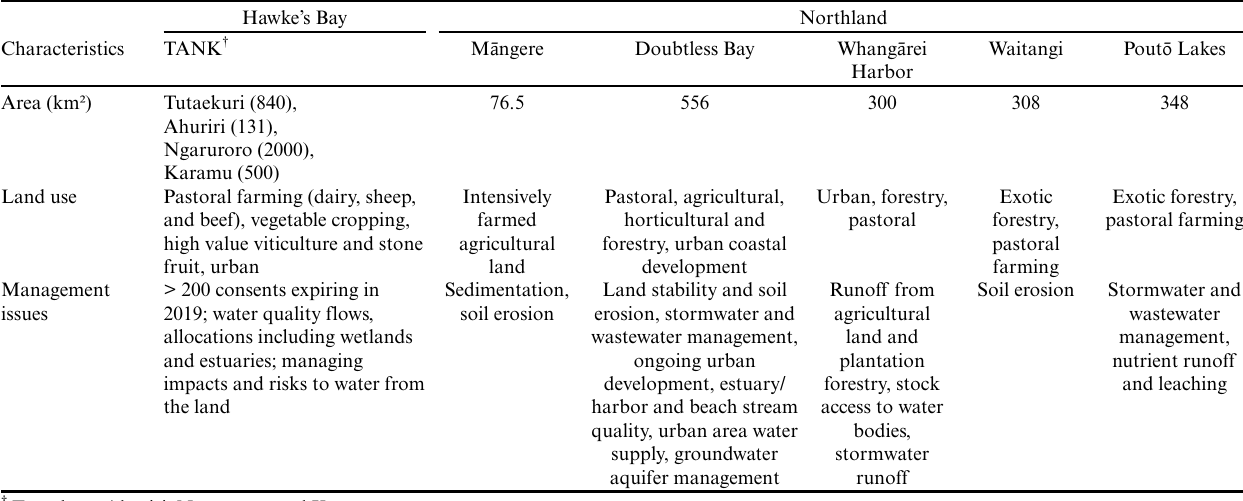
Table 1 . Land use and management issues for case study catchments.